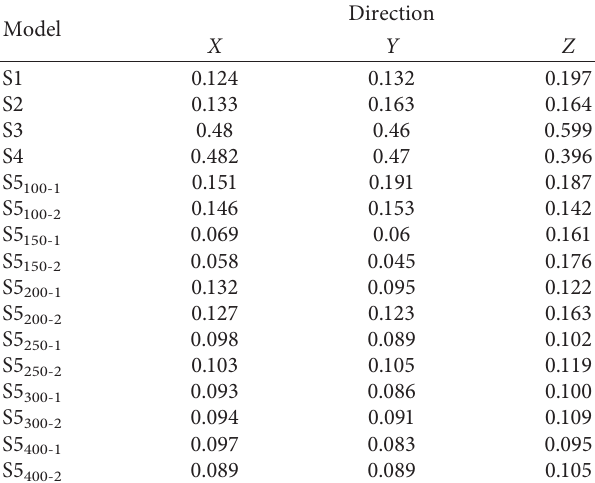
Table 3: Average TC values of the model.